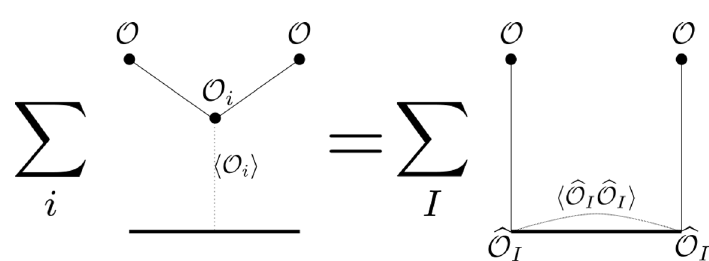
Figure 3. Pictorial representation of (2.10). The thick line represents the boundary; thin lines represent fusion of external operators into bulk or boundary operators; dotted lines represent